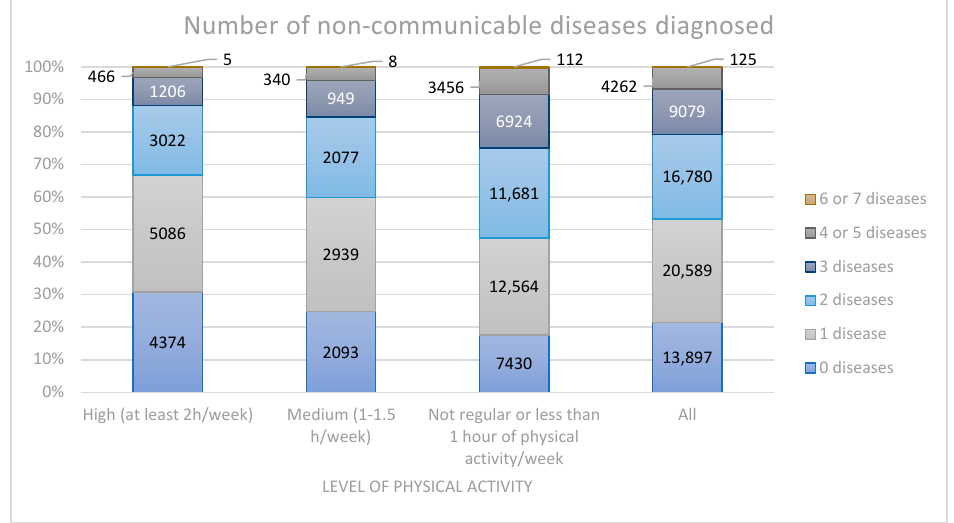
Figure 1. Number of non-communicable diseases diagnosed. Half (50.7%) of respondents from the most active group rated their physical health as “good” and 26.6% as “very good”. Similarly, in the medium physical activity group, half of the respondents (50.7%) rated their physical health as “good”, followed by 31.3% who rated it as “average (neither good, nor bad)”. Only 15.2% from this group thought their physical health was very good. The biggest part of the least active group (42.9%) rated their physical health as “average”, 39.8% as “good” and only 9.1% as “very good”. Figure 2 presents these findings. Int. J. Environ. Res. Public Health 2023 , 20 , x FOR PEER REVIEW